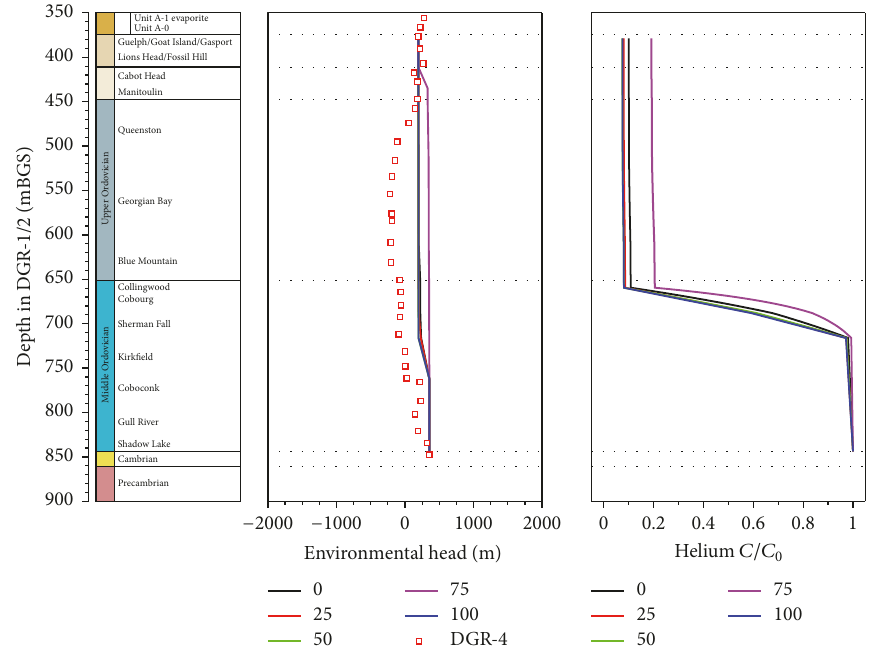
Figure 11: Simulation of helium unit tracer over 260 Ma using calibrated vertical hydraulic conductivities for glaciation scenario nn9921 for calibrations using a hydrostatic head condition computed assuming steady-state. Coloured lines represent different percentages of ice-sheet thickness applied as excess head to the top boundary condition.